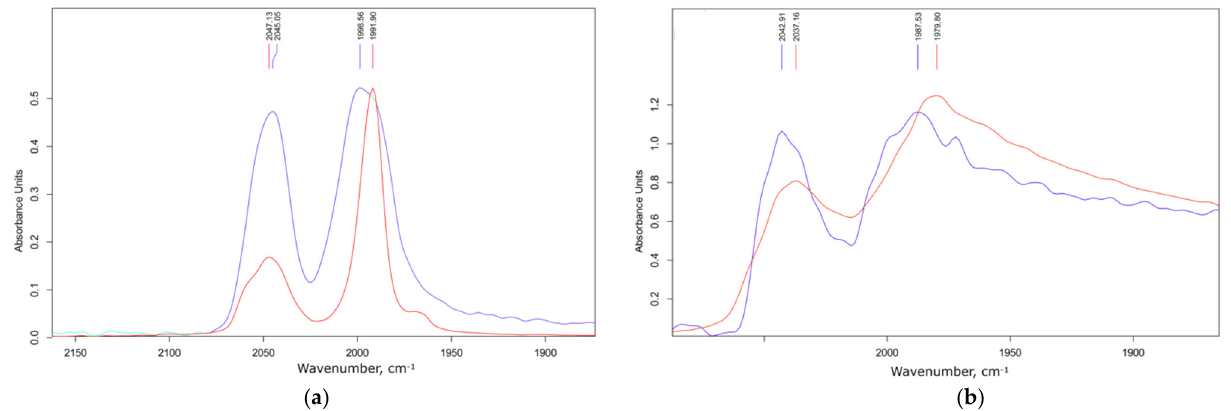
Figure 4. Overlay of the fragments of IR (ATR) spectra of pure CpFe(CO) 2 Cl (red) and cocrystal 1 (blue, a ); overlay of CpFe(CO) 2 Br (red) and 2 (blue, b ).